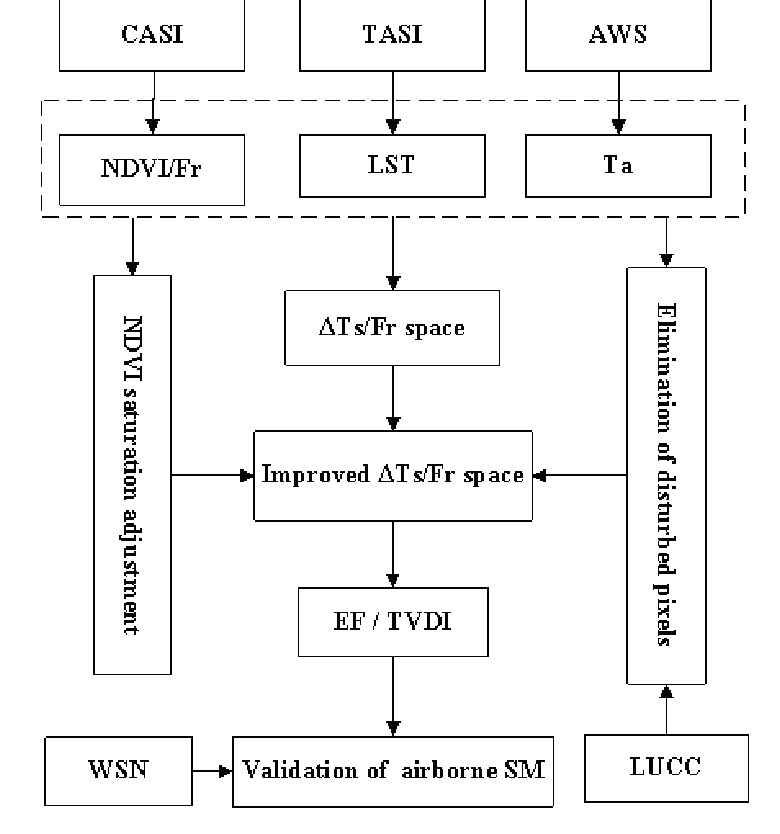
Figure 4. Algorithm flowchart for this research.